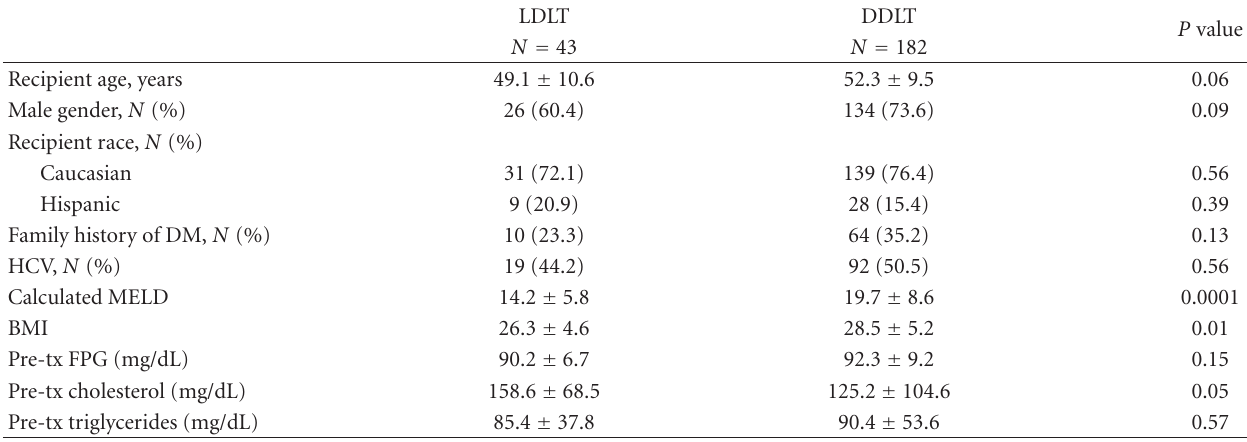
Table 2: Pretransplant demographics of living-donor and deceased-donor